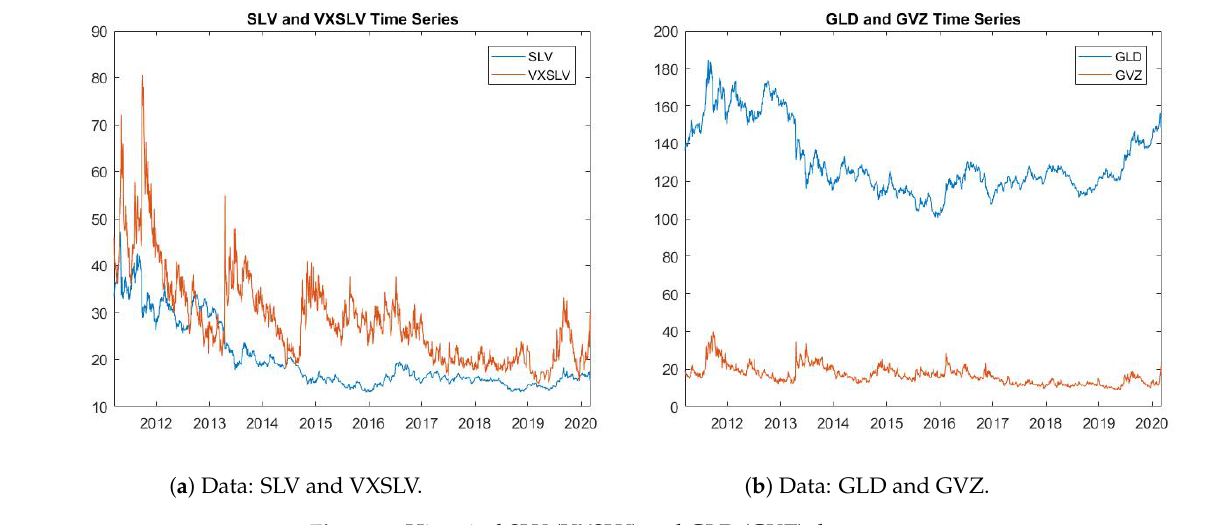
Figure 3. Historical SLV (VXSLV) and GLD (GVZ)